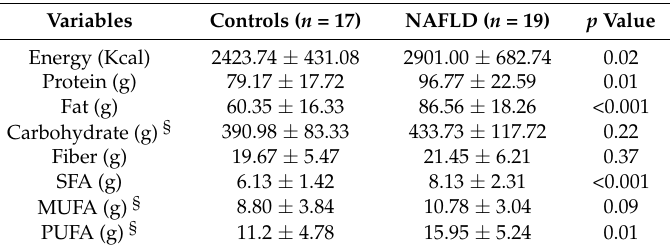
Table 2. Dietary intakes of participants.